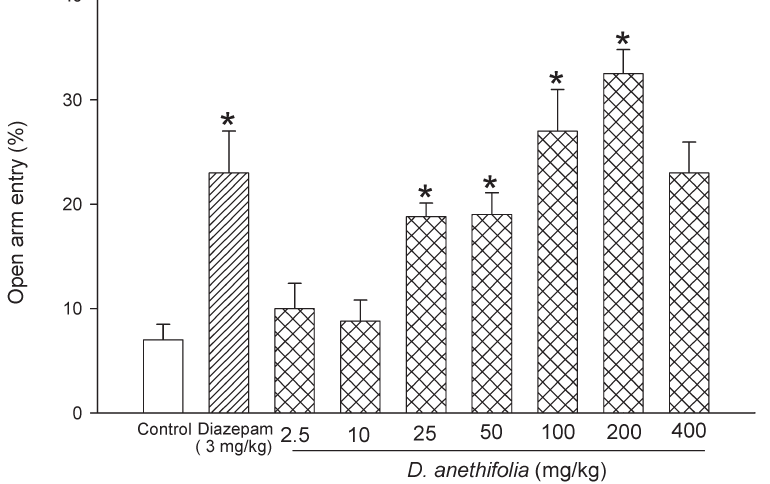
Figure 2 - Effects of diazepam, saline, and different doses of D. anethifolia extract on percentage entries in the open arms during a 5- minute test in mice. Test compounds were injected 30 minutes prior to the EPM test. Data are presented as mean values ( ¡ S.E.M.). *P , 0.05 compared with vehicle-treated